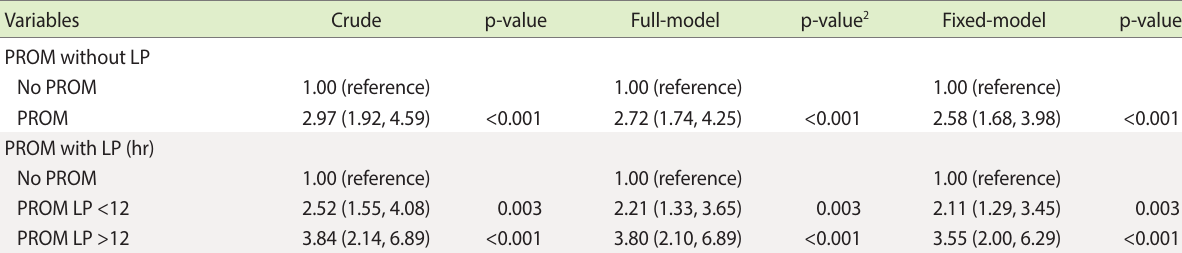
Table 3. Association between LP of PROM and preterm labor 1 Variables